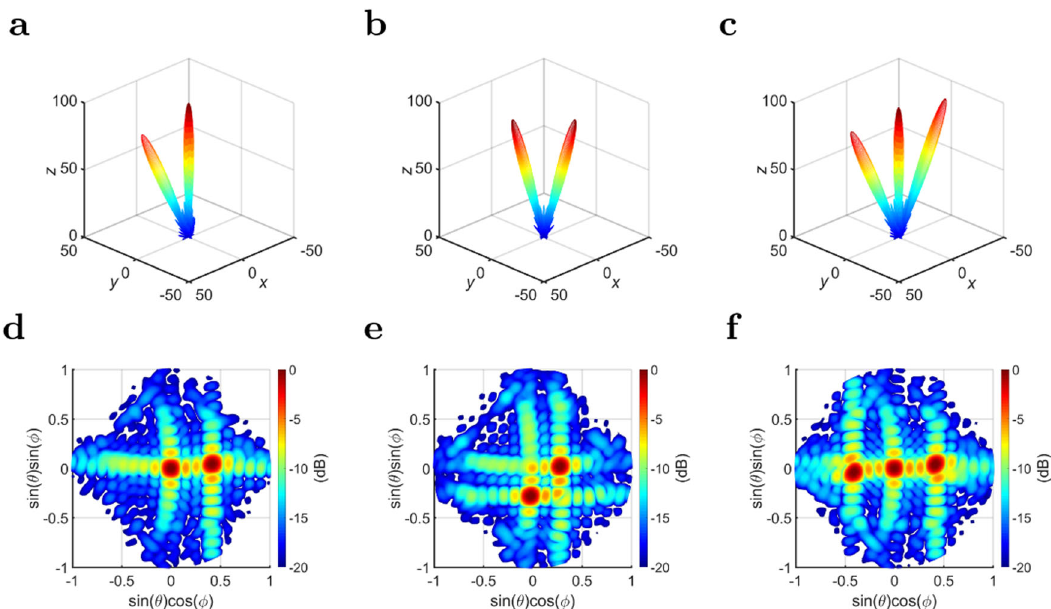
Fig. 4 Multiple-beam simulation. The normalized full-wave simulated radiation patterns for various values of ( ψ ), when both sides A and B (and C) of the 15 × 15 PEX array are excited simultaneously. a – c The full-wave simulated far- fi eld 3D gain patterns for the cases: a ψ = 0° and 285°, b ψ = − 10° and 280°, and c ψ = 0°, 285°, and 105°, plotted in linear scale (V/m) and normalized to an arbitrary value of 100. d – f The full-wave simulated far- fi eld U-V gain patterns for the cases: d ψ = 0° and 285°, e ψ = − 10° and 280°, and f ψ = 0°, 285°, and 105°, plotted in dB scale. All the beams can be independently scanned, and a multitude of radiation directions are